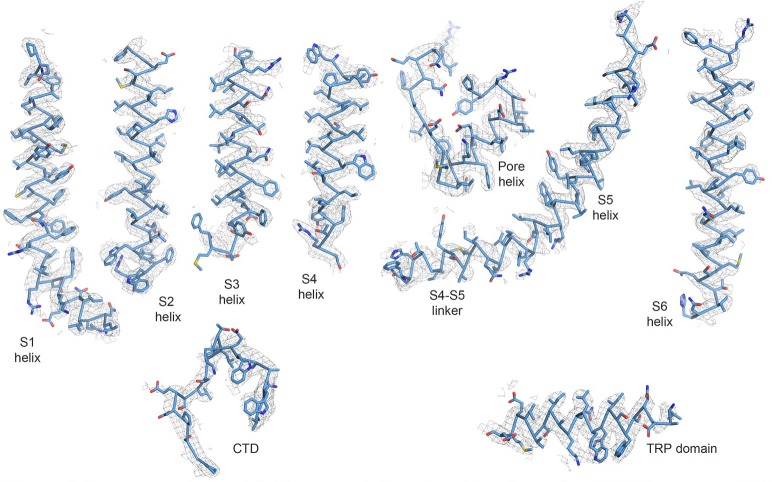
Representative densities from the TRPV2CBD_2 cryo-EM map.Densities are contoured at σ = 5.